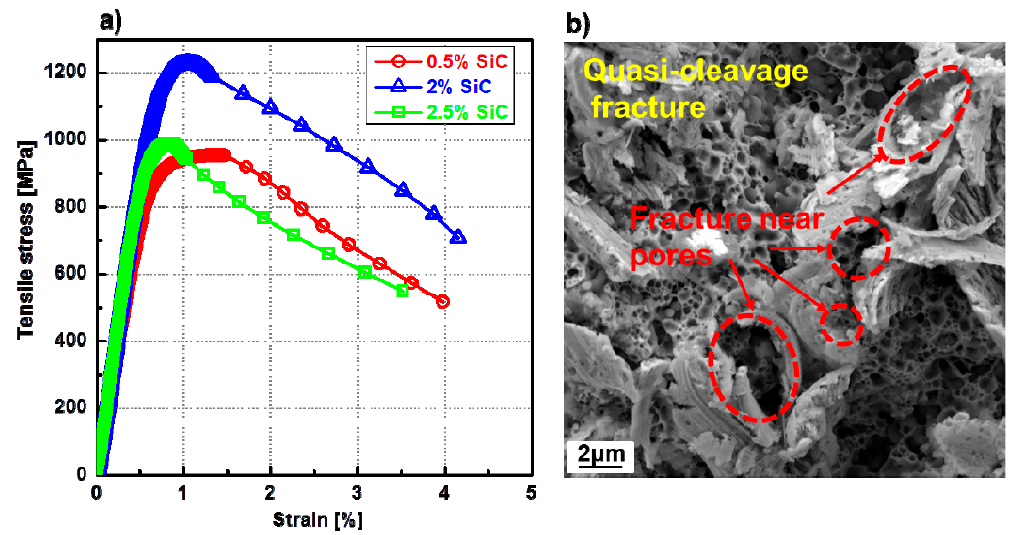
Figure 2. ( a ) Stress-strain curves of 48-h-milled NiMo-SiC DPS alloys with an increasing amount of SiC in the initial powder mixture, and ( b ) SEM image of relative fracture tomography (shown at 10 nm resolution).